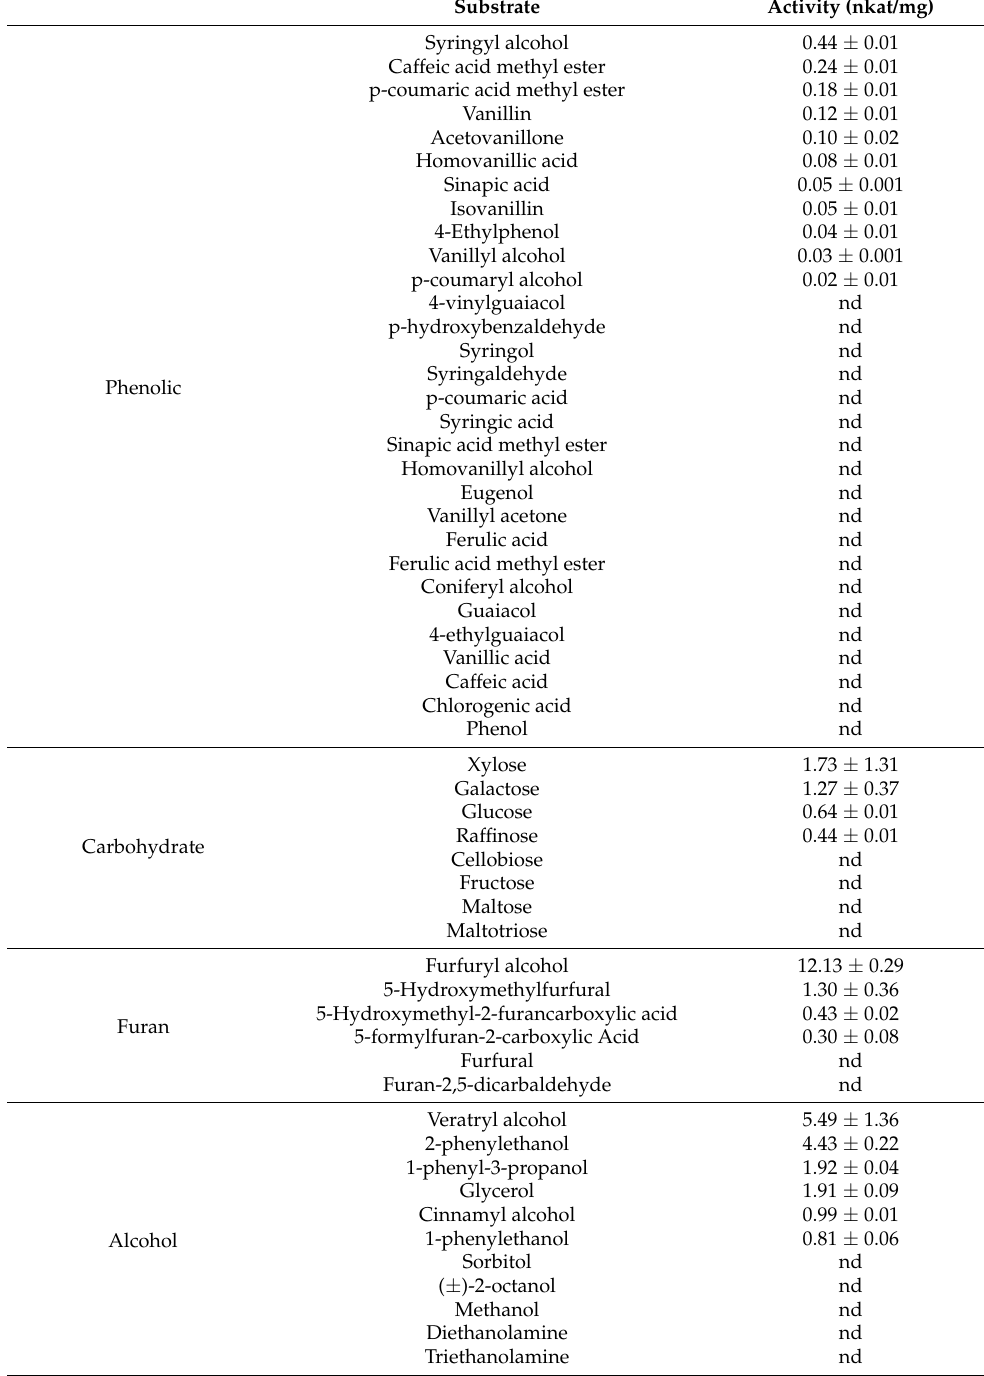
Table 1. Substrate specificity of Tr